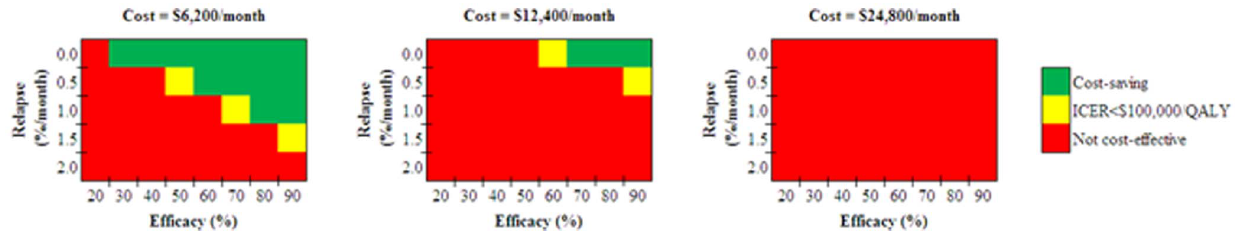
Figure 3. Stem Cell Transplantation compared to standard of care ART. The figure depicts the cost-effectiveness of Stem Cell Transplantation compared to standard of care ART as a function of the three influential parameters identified via the one-way sensitivity analysis in Table 3: cost, relapse rate, and efficacy. In each panel, the horizontal axis denotes efficacy while the vertical axis denotes the relapse rate. Inside each panel, the shading denotes the resultant cost-effectiveness finding, ranging from cost-saving (green), through cost-effective (with an ICER , $100,000/ QALY, yellow), to not cost-effective ( $ $100,000/QALY or more expensive and less effective than ART, red). Instances where the intervention is both less expensive and less effective than ART are denoted in blue, but most were not cost-effective because the ICER of ART was , $100,000/QALY compared to SCT. The plus sign indicates a strategy that had an ICER for ART compared to SCT . $100,000/QALY gained. ART: antiretroviral therapy; ICER: incremental cost-effectiveness ration; QALY: quality-adjusted life year.